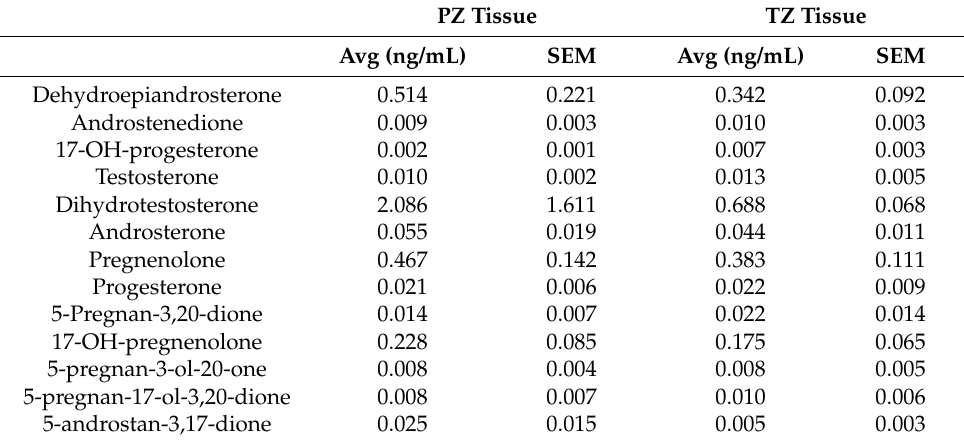
Table 1. Intrinsic steroid levels in peripheral zone (PZ) and transition zone (TZ) tissues of human prostate cancer patients. Results are expressed as mean ± SEM (PZ n = 6; TZ n = 7). No statistical differences were found between the steroid levels in different zones of the prostate